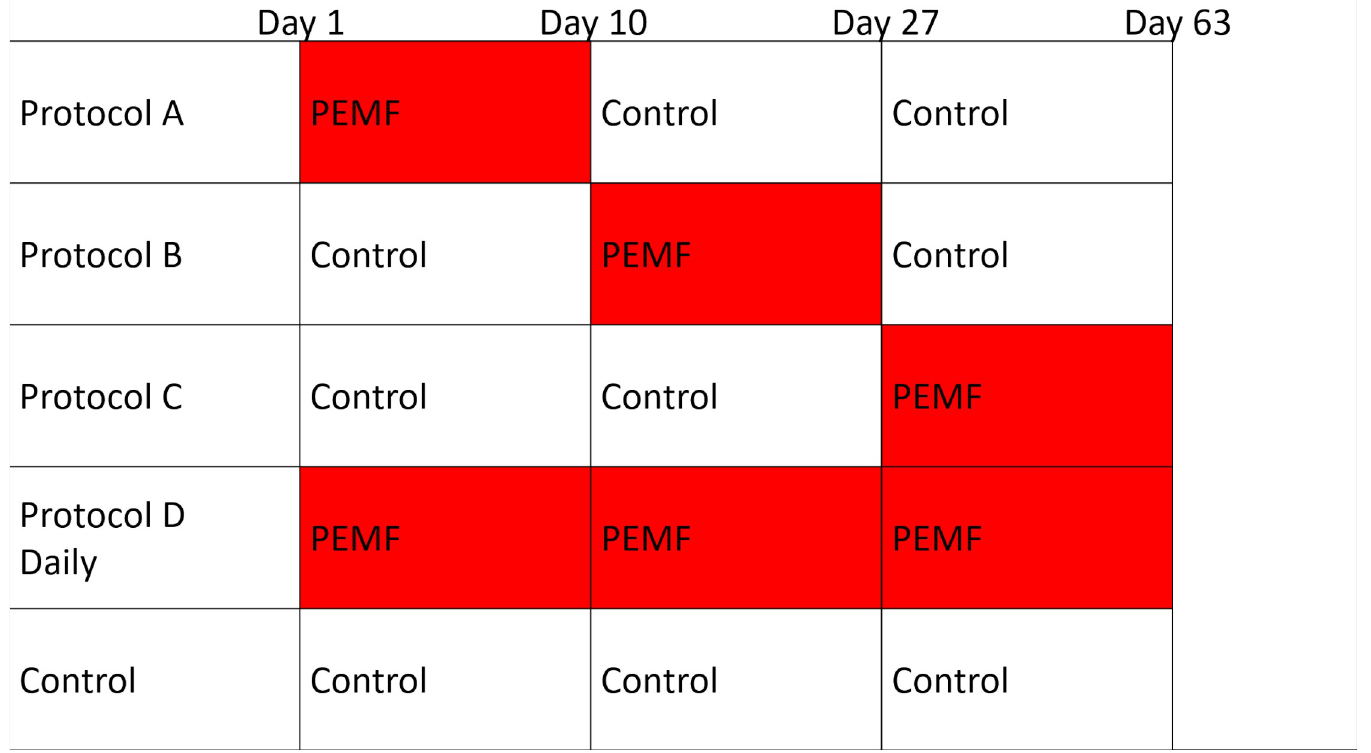
Fig 3. Protocols for application of PEMF during ring culture.